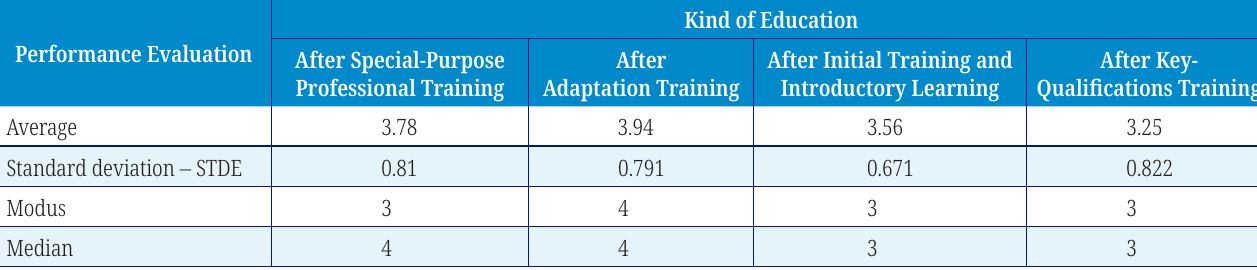
Table 4. Selected descriptive statistics of employee performance evaluation